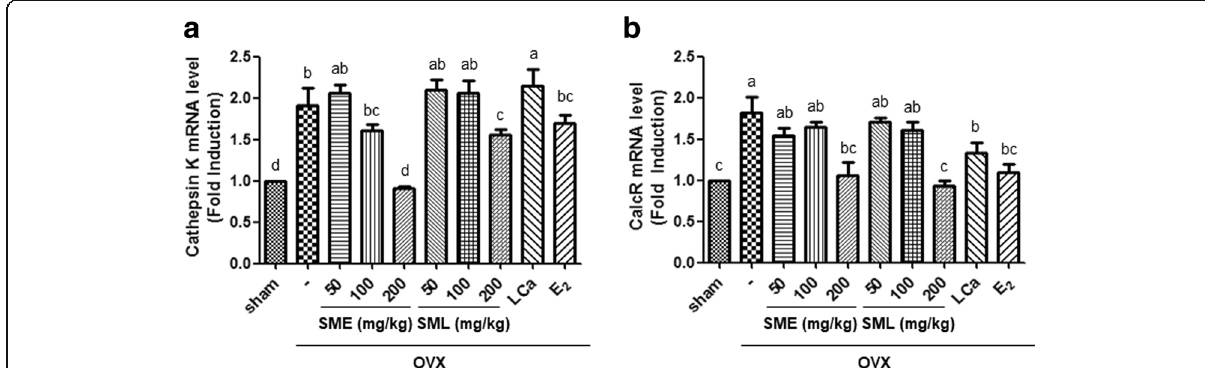
Fig. 5 Effects of SML on the expression of cathepsin K and calcitonin receptor (CalcR) in OVX mice. RNA was extracted from the bone marrow cells of OVX mice, and a the mRNA levels of cathepsin K and b calcitonin receptor were assessed by real-time PCR assay. β -actin was considered an internal control. Data are the mean ± S.E.M. of three independent experiments ( n = 7) for all groups. Means unlike letters in a column with differ significantly ( p < 0.05)